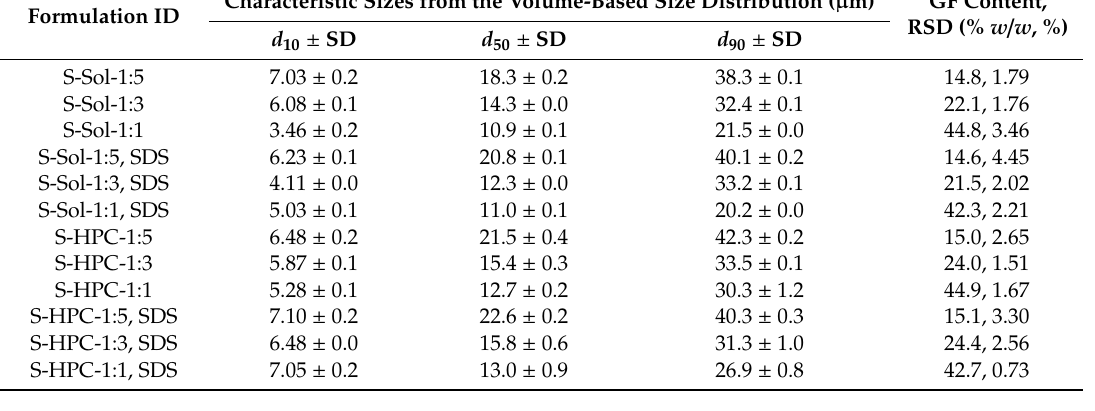
Table 3. Particle sizes of the powders prepared via spray drying and their drug content. Formulation ID Formulation ID